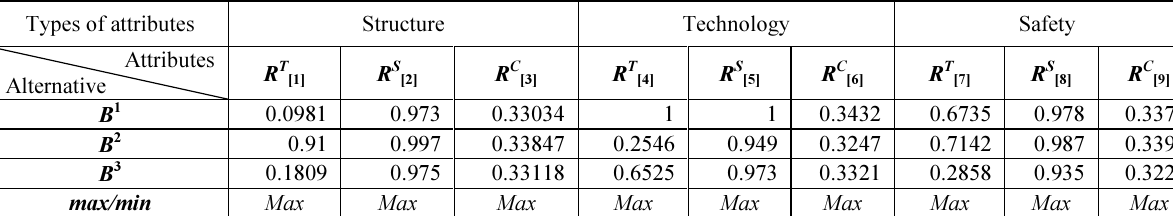
Table 7. The rationality and ranking of alternative combinations Rationality Ranking Combinations